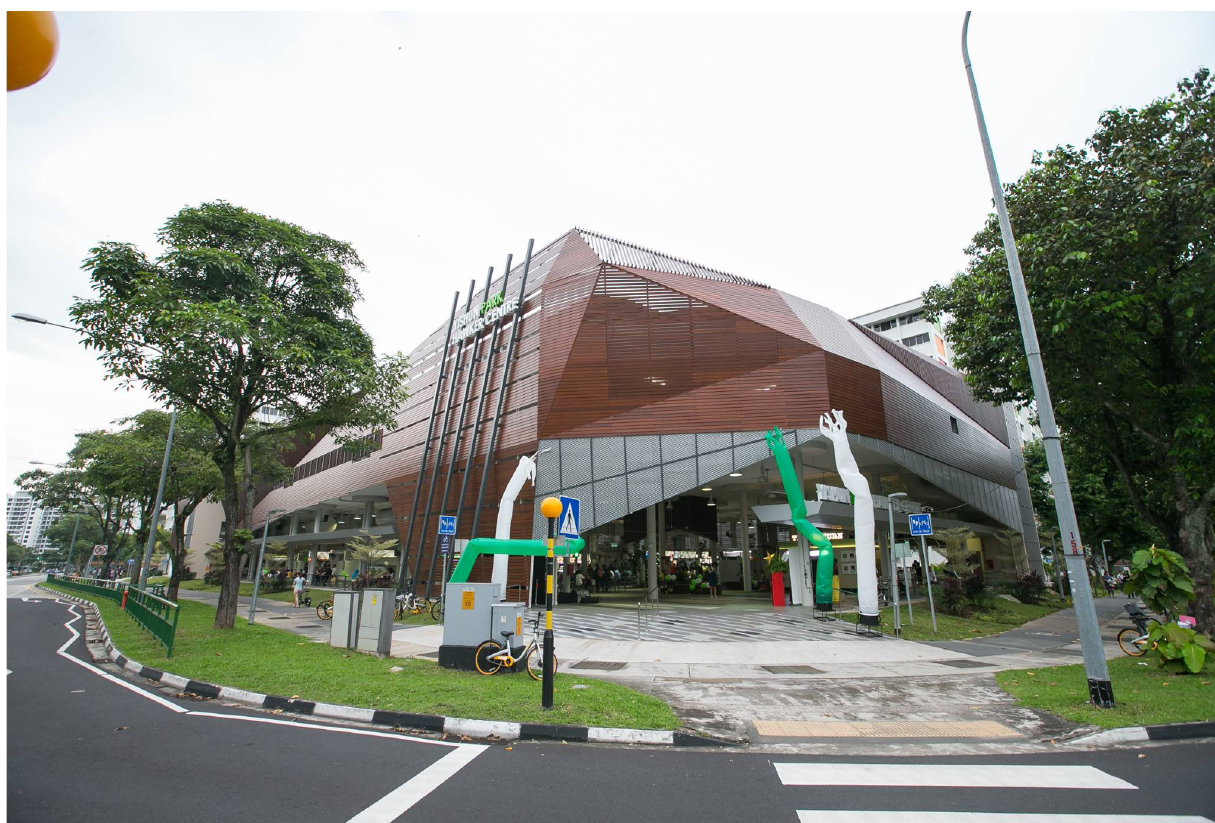
Figure 3. Yishun Park HC. Source: Courtesy of Yishun Park